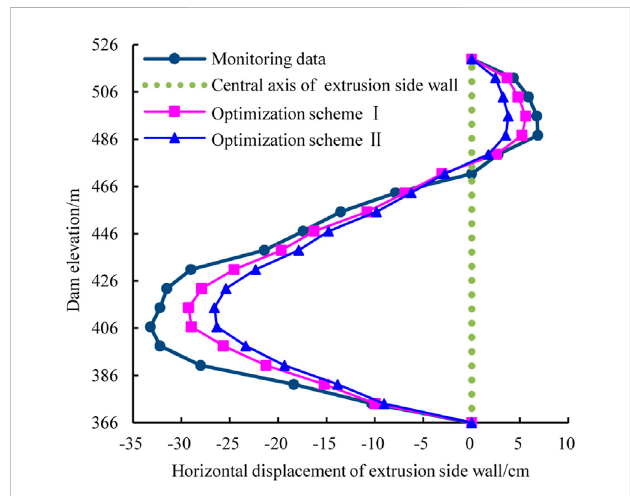
FIGURE 17 Displacement of Squeezing sidewall along the elevation along the